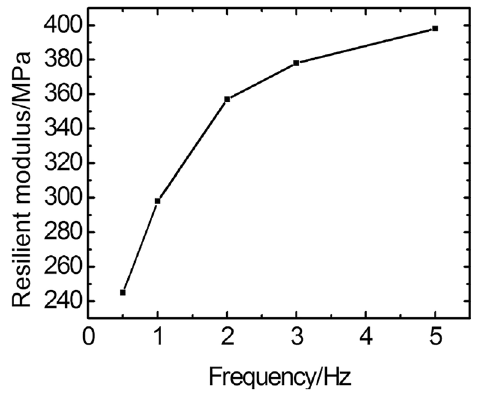
Fig. 9 Influence of the frequency on the resilient modulus